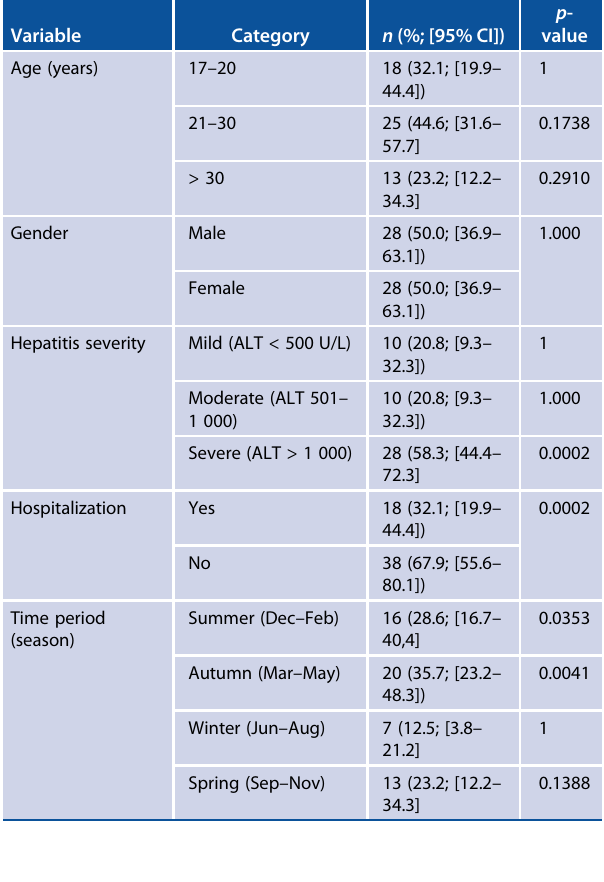
Table 2: Demographic characteristics for adults presenting with acute hepatitis